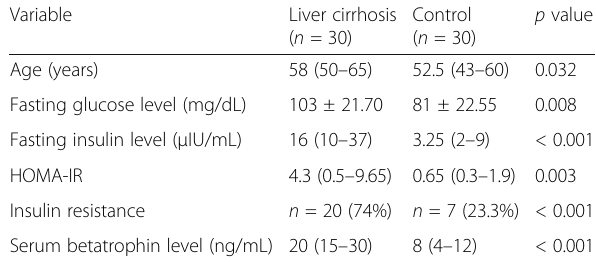
Table 1 Comparison between liver cirrhosis patients and controls Variable